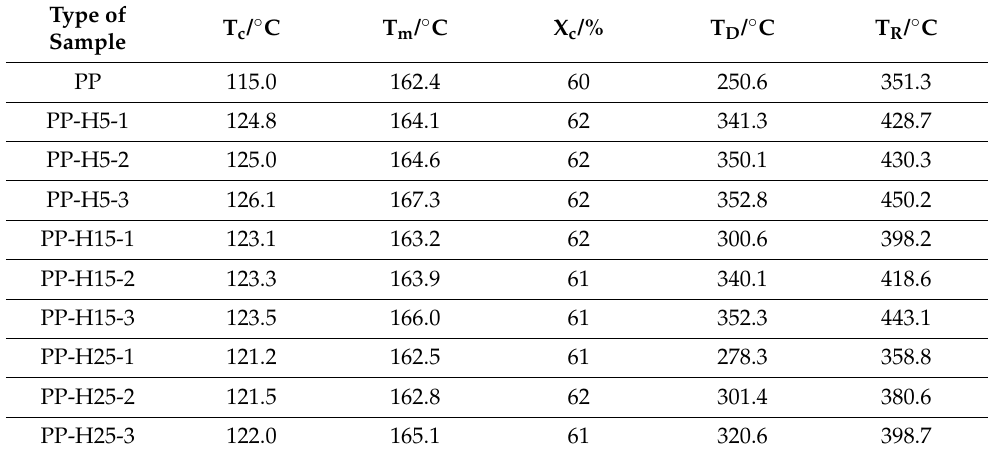
Table 4. The thermal and crystalline characteristics of the produced